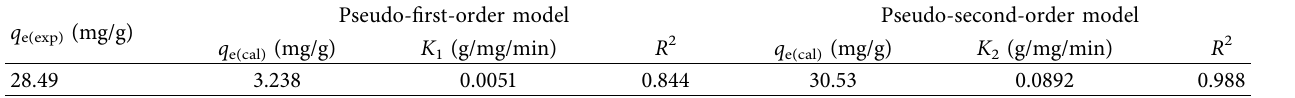
Table 3: Kinetic adsorption models.